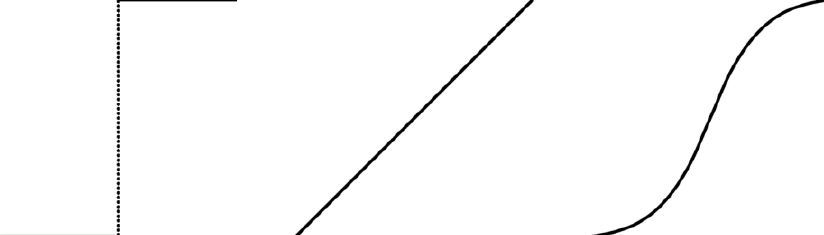
Figure 3. The curvature of the transition cases (Left: No transition curve. Middle: Clothoid transition curve. Right: S- shaped transition curve).